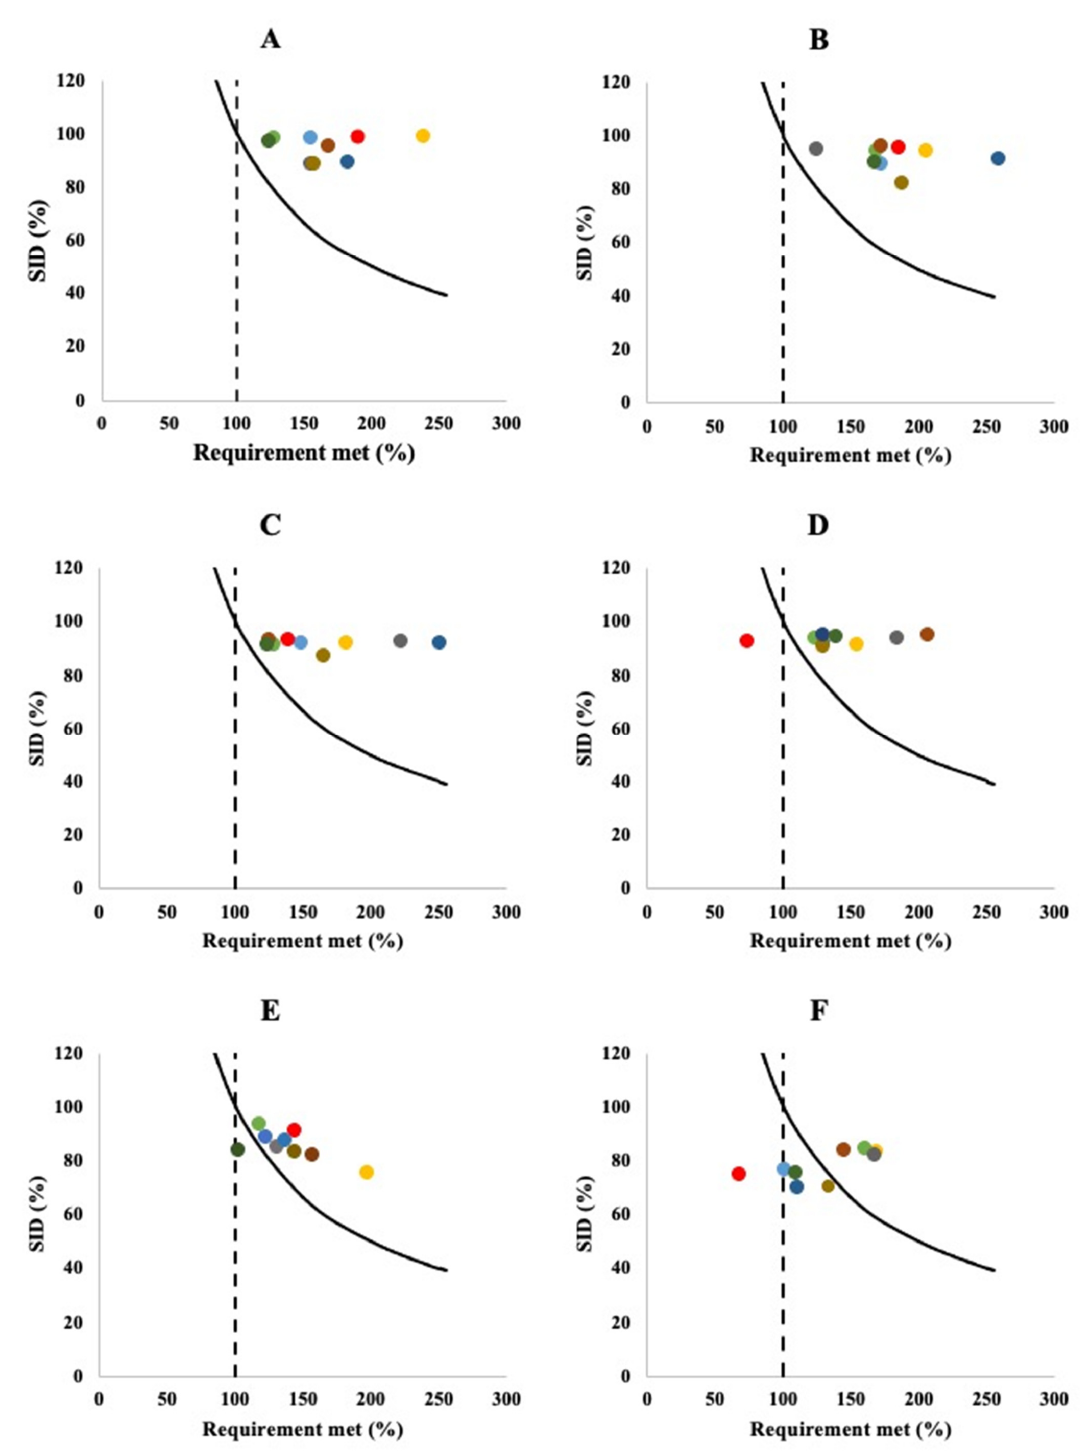
Figure 7. Concentration (expressed as a percentage of the recommendation for adults outlined in Table 2) and standardized ileal digestibility (SID) for histidine ( • ), isoleucine ( • ), leucine ( • ), lysine ( ), sulphur containing amino acids ( ), aromatic amino acids ( ), threonine ( ), tryptophan ( ) and valine ( ) in pork belly; - - - : adequacy marker for amino acid requirement; ⎯⎯ : cut-off for actual requirement as a combination of amino acid content and digestibility of the respective indis- pensable amino acid; ( A ; data from [76]), skim milk powder ( B ; data from [57]), soy flour ( C ; data from [57]), rice ( D ; data from [80]), cooked peas ( E ; data from [87]) and maize ( F ; data from [80]).